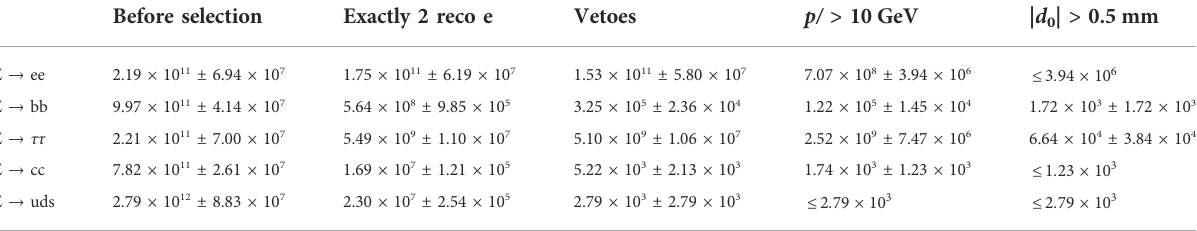
TABLE 2 The expected number of events at an integrated luminosity of 150 ab − 1 is shown for the background processes, for each selection criterion. Before selection